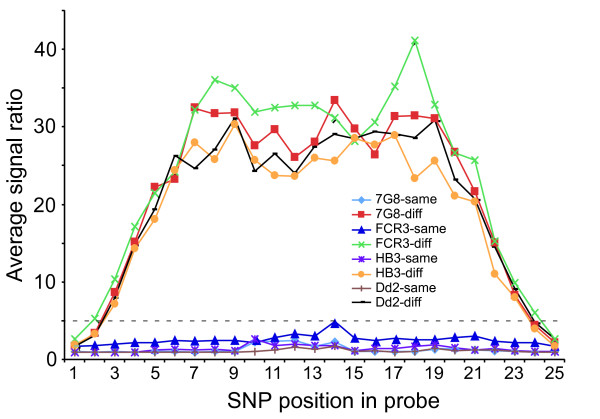
Relationship between probe signal ratios and SNP positions. 7G8-same indicates signals from probes with no known NIAID SNP within the probes between 3D7 and 7G8 parasites (3D7/7G8); 7G8-diff indicates probes with known differences between 3D7 and 7G8 parasites. The definitions for the rest of the parasites (FCR3, Dd2, and HB3) are the same as those for 7G8. The dashed line indicates signal cutoff ratio value of 5.0.